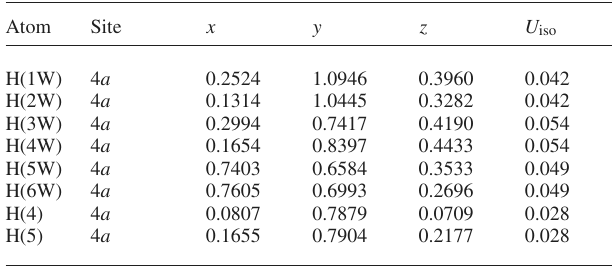
Table 2. Atomic coordinates and displacement parameters (in Å 2 ) .